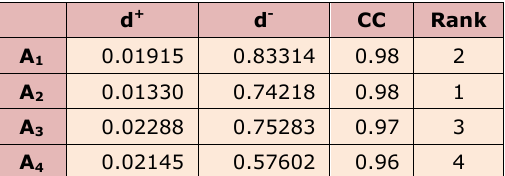
Table 8. Final evaluation of the